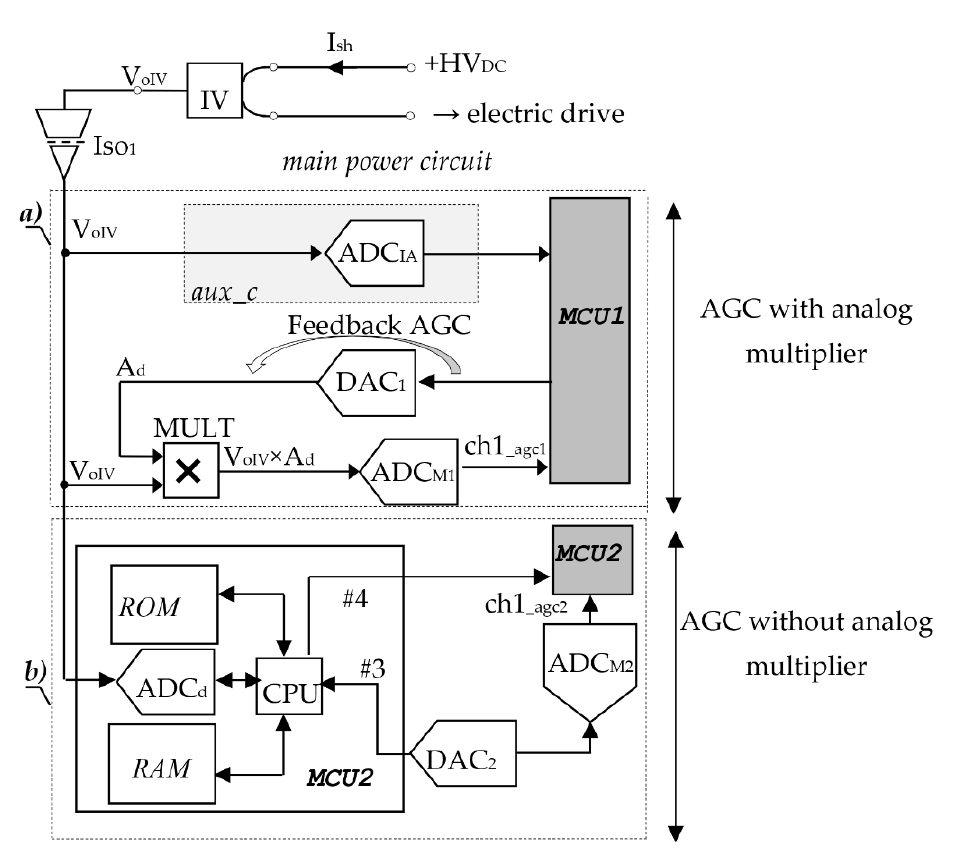
Figure 3. Fuzzy AGC controller circuit: ( a ) Using the analog multiplier (MULT); ( b ) using only the microcontroller (MCU2).